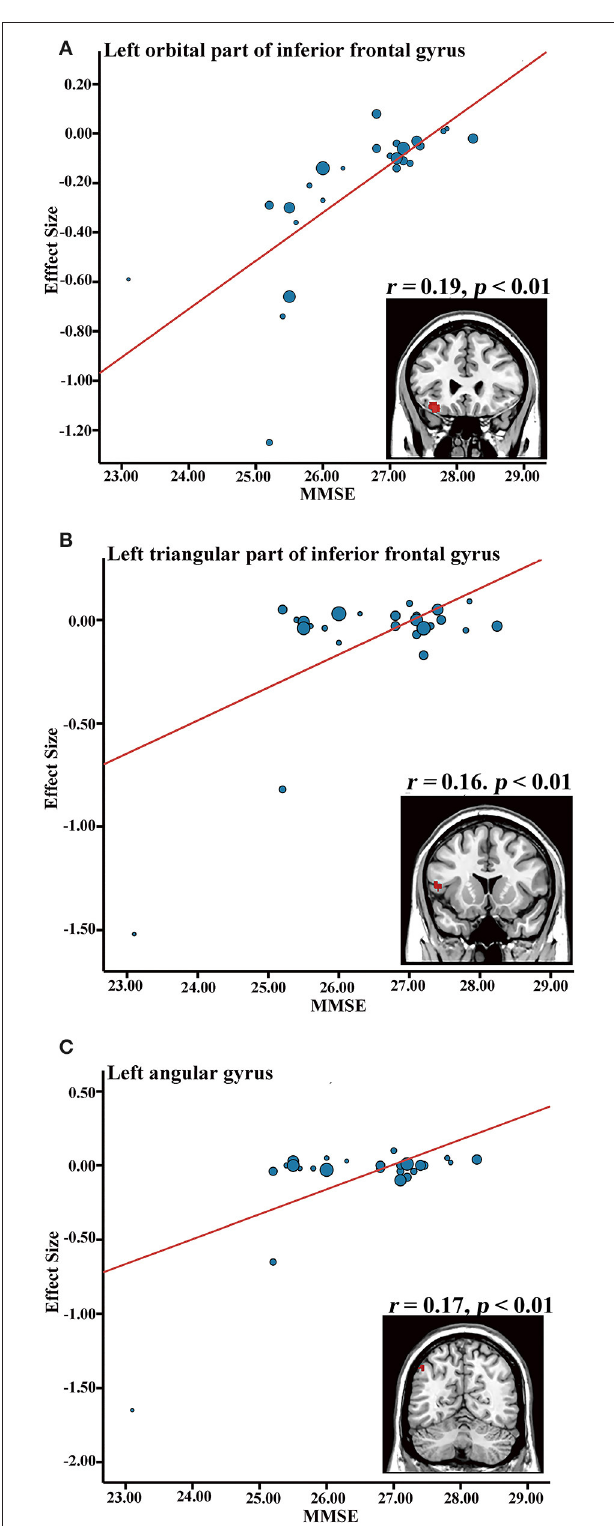
FIGURE 4 | Meta-regression results showing an association between MMSE and gray matter volume in the aMCI group, in the left inferior frontal gyrus (A) , left inferior frontal gyrus (B) , and left angular gyrus (C) . MMSE, mini-mental state